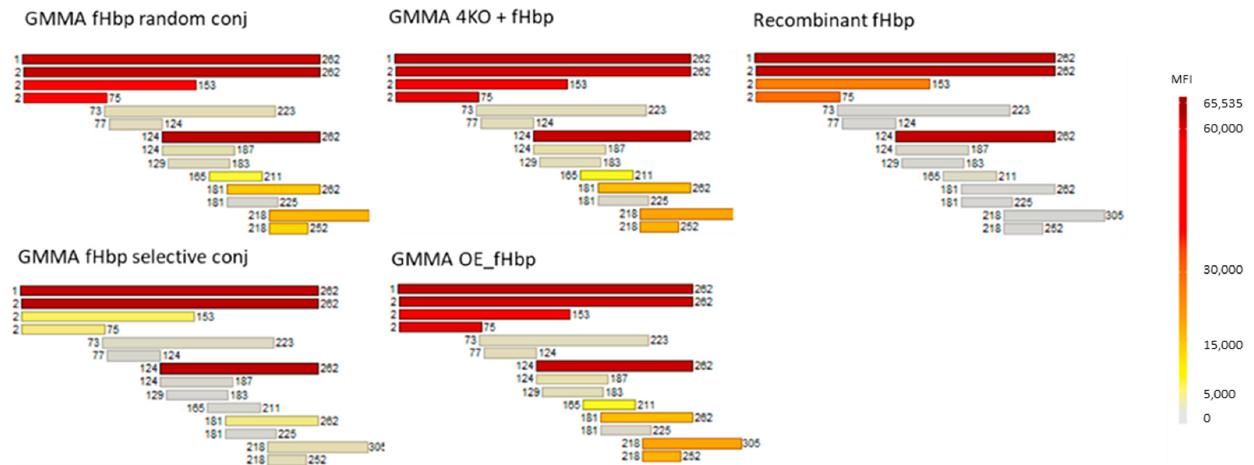
Figure 3. Protein microarray reactivity profile of pooled sera collected two weeks after the third immunization (day 35) with fHbp constructs, normalized according to ELISA titers. Each horizontal bar represents a single protein or protein fragment spotted in the microarray for fHbp v3.28 and color changes from light gray to dark red according to increasing mean fluorescence intensity (MFI) values, as shown in the vertical bar.